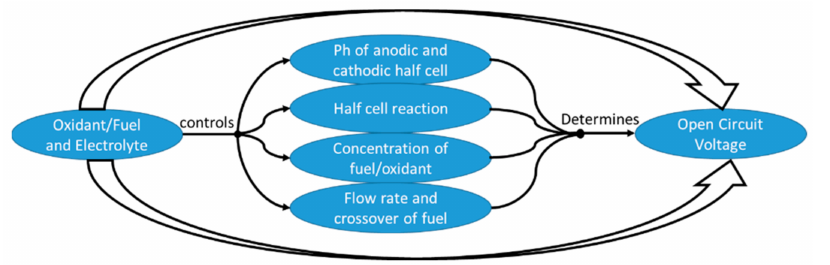
Figure 13. Concept map for the impact of oxidant, fuel, and electrolyte on the open-circuit voltage of